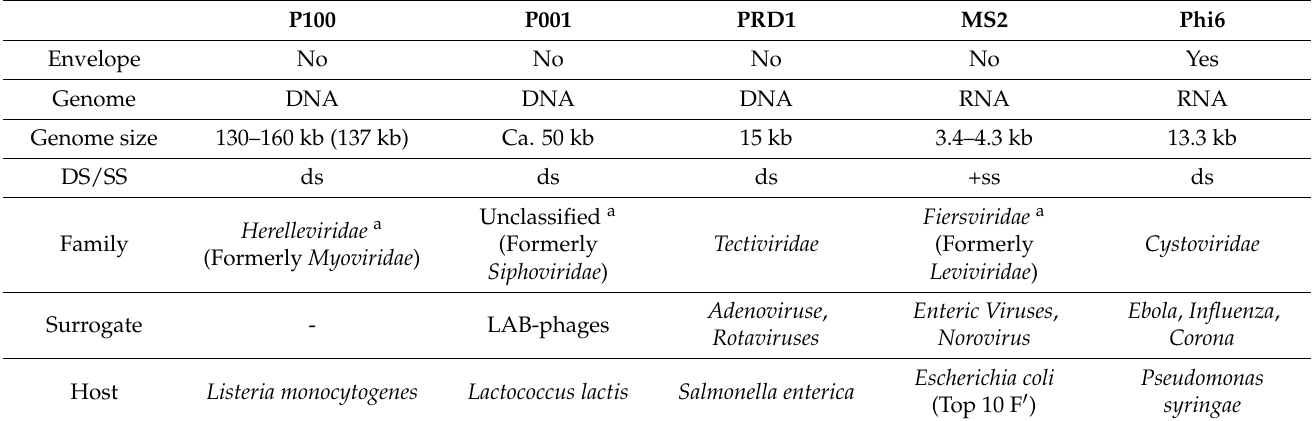
Table 2. Virus characterization and their